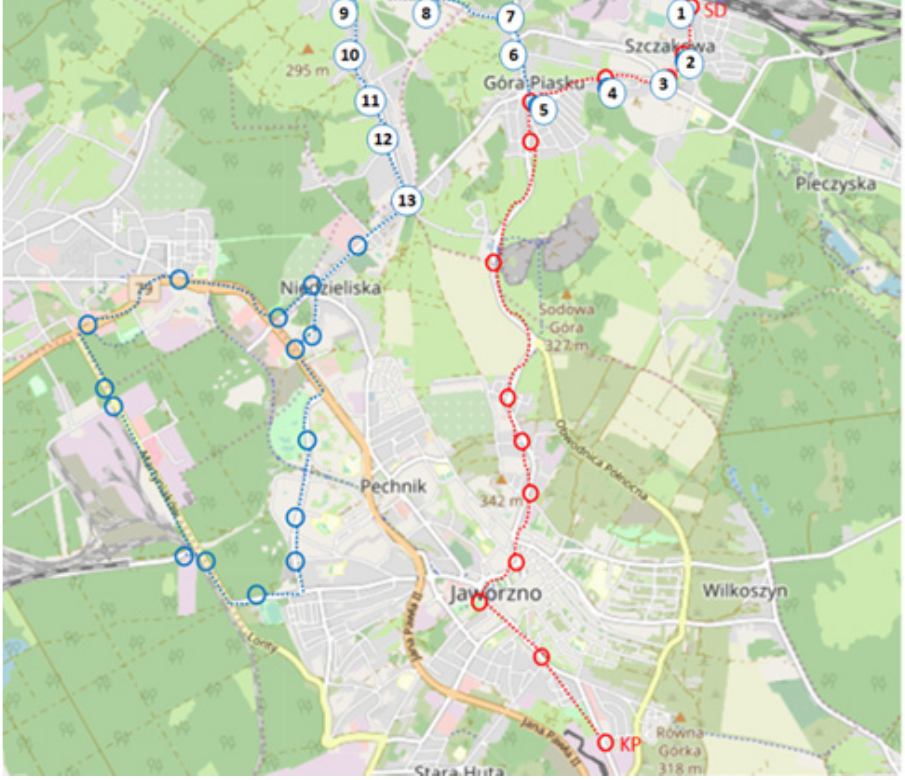
Figure 1. Routes of analyzed bus lines. source:"© autorzy OpenStreetMap"